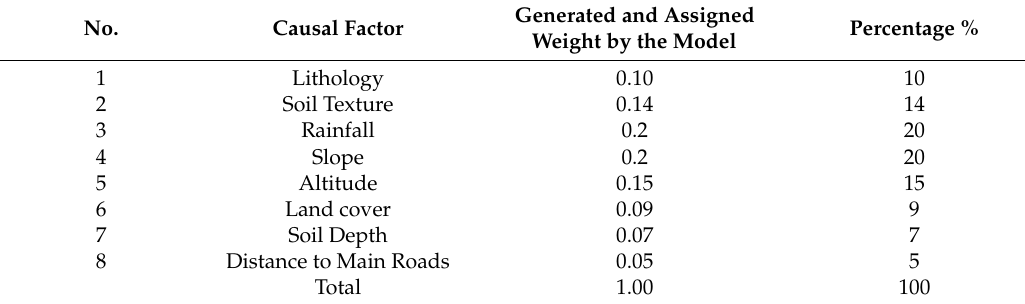
Table 4. Generated weights for causal factors in GIS-LWIS_SMCE. This table highlights weights generated by the model basing on past landslides